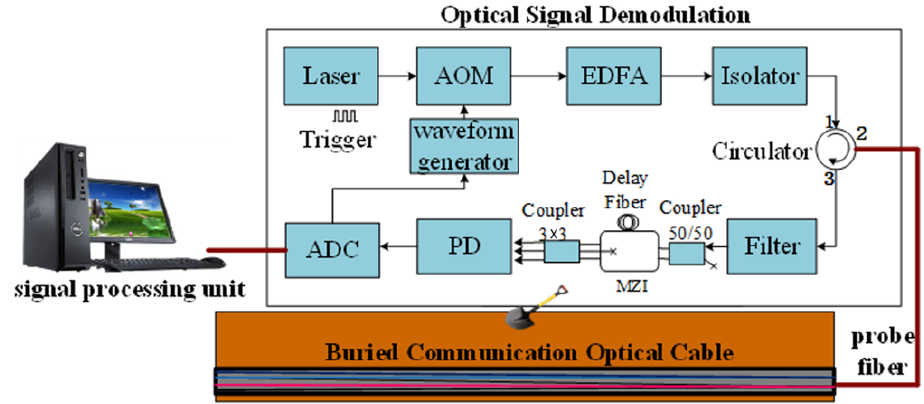
Figure 2. Experimental setup for data collection in the field.